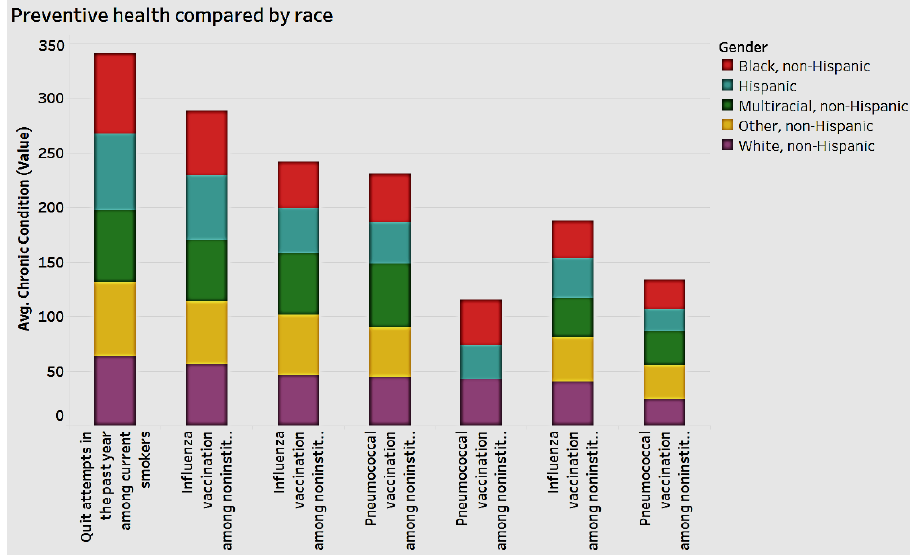
Figure 13. Preventive health by race.